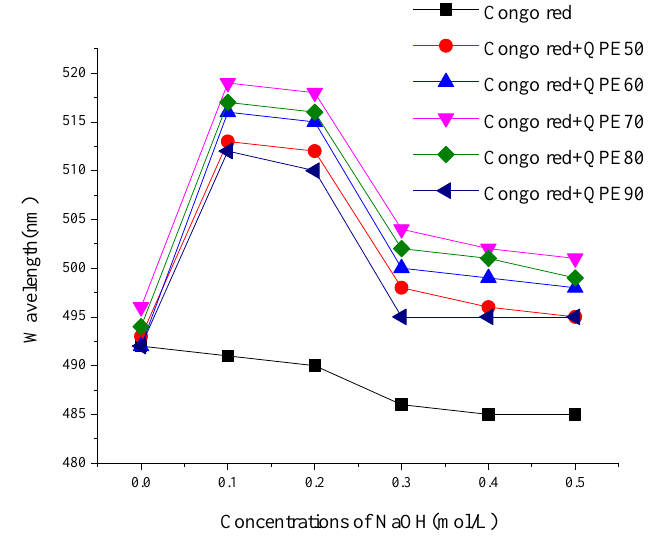
Figure 2. Congo red test results of QPs.